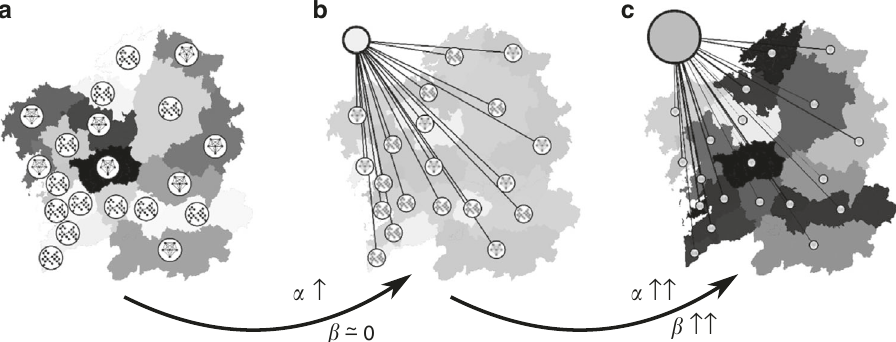
Fig. 4 Schematic representation of dynamic rates as the coupling of urban areas to a mean- fi eld node is made predominant. a Within the proposed model, for low values of both α and β , speakers within each region evolve mostly independently following its own internal dynamics. Our data indicates that prominently urban regions evolve slower than rather rural regions in this regime. This is in accordance with computational results from ref. 35 , who predict slower convergence time for more complex networks. b Allowing nodes to interact (in our model, through a mean- fi eld node) diffuses this effect. c If connectivity to the mean- fi eld node favors more urban areas (which makes intuitive sense, given the ability of urban areas to collect and cast net-wide trends), our model predicts that prominently urban areas should evolve faster when compared to rather rural areas — i.e., connectivity at a mesoscale